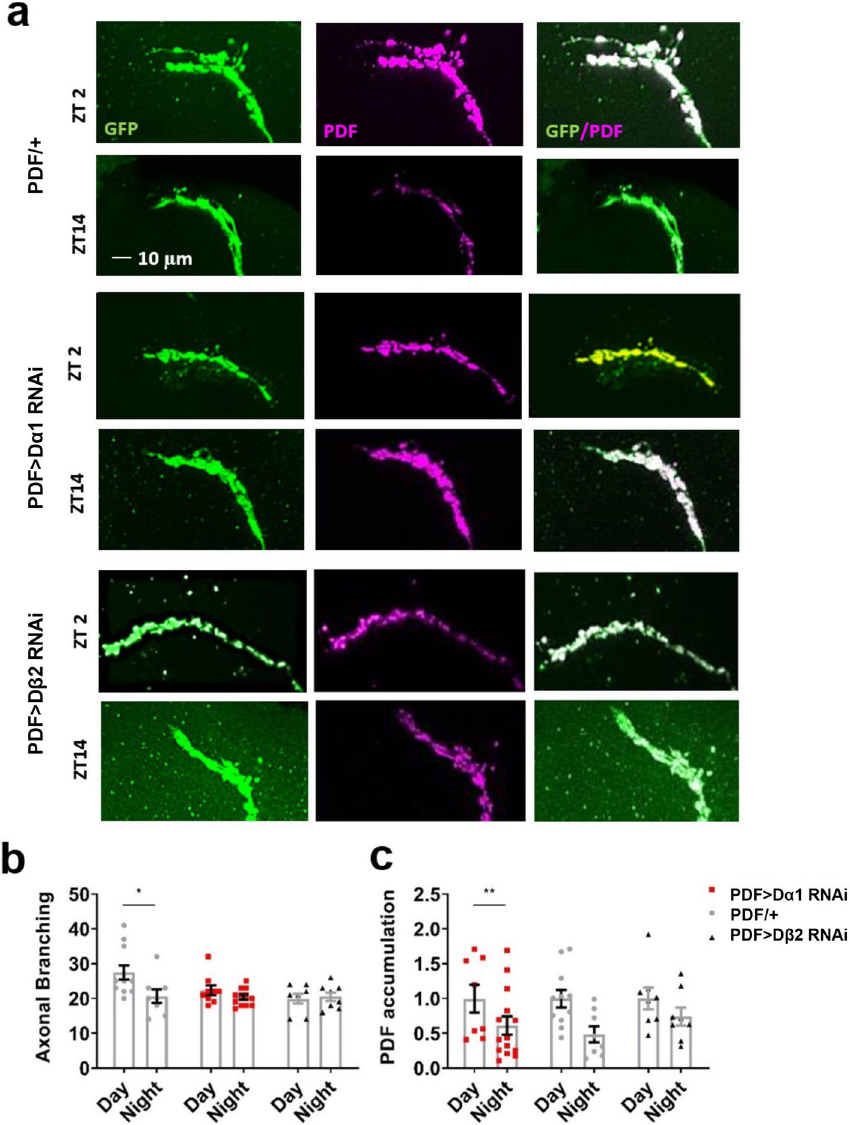
Figure 6. Knockdown of Dα1 or Dβ2 disrupted the day/night remodelling and PDF cycling of the s-LNv dorsal terminals. ( a ) Representative confocal images of the s-LNv dorsal terminals of control flies ( PDF-Gal4/ +) and flies with Dα1 ( PDF-Gal4 > uas-nAChR-Dα1-RNAi ) and Dβ2 ( PDF-Gal4 > uas-nAChR-Dβ2-RNAi ) knocked down in LNv clock neurons taken in the day (ZT2) and night (ZT14). ( b ) The s-LNv dorsal terminals of control flies showed greater branching complexity in the day than at night ( t 17 = 2.3, p = 0.036), this day/night difference in terminal complexity was removed in PDF > Dα1-RNAi ( t 19 = 1.4, p = 0.183) and PDF > Dβ2-RNAi ( t 13 = -0.7, p = 0.515) flies. ( c ) PDF accumulation in the s-LNv dorsal terminals was greater in the day than at night for control flies ( t 17 = 2.9, p = 0.010), but not in PDF > Dα1-RNAi flies ( t 19 = 1.8, p = 0.089) and PDF > Dβ2-RNAi flies ( t 14 = 1.3, p = 0.218). Each data point represents a single brain, n = 6–15